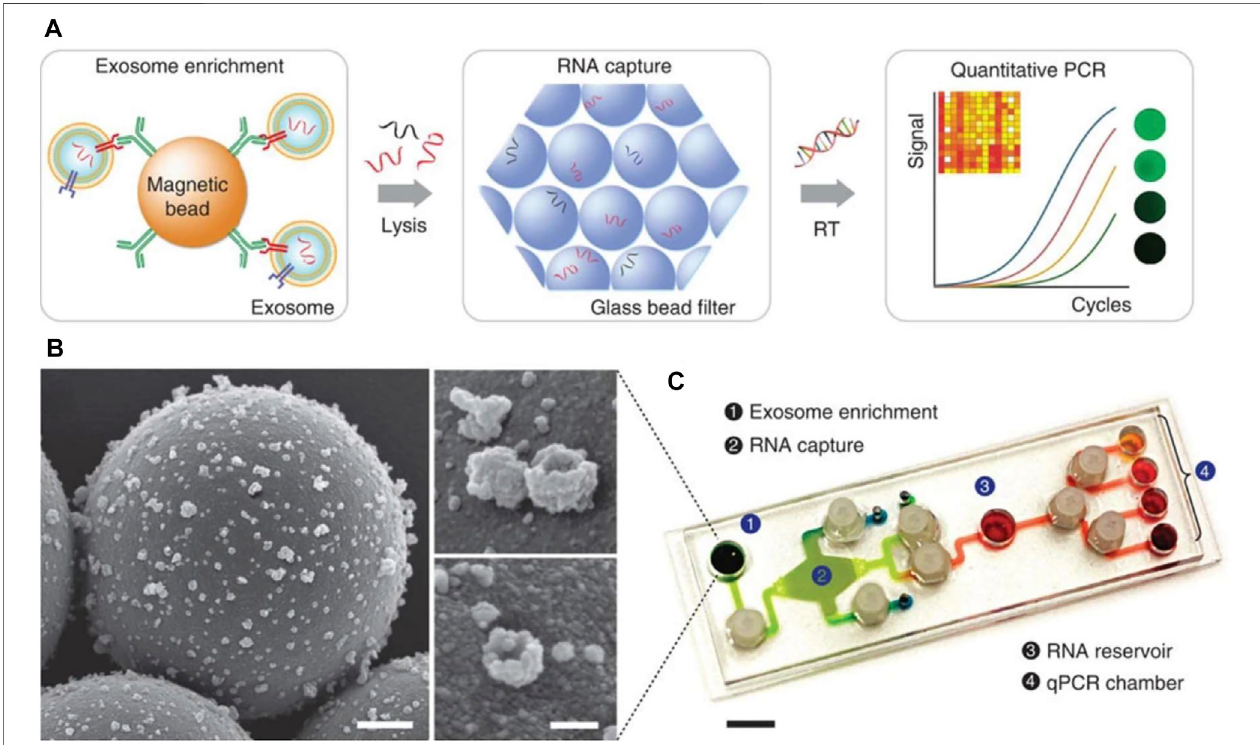
FIGURE6| Diagramofkeysteps/approachesformeasuringexosomeforthepredictionofCVD. (A) Magneticmicrobeadscoatedwithspeci fi cantibodiesenabled exosomeisolationandadditionofguanidine-basedlysisbufferreleasedthecontentsofenrichedexosomes.Torque-actuatedvalvesandpermanentmagnetswereused to control the process. RNA is adsorbed on a glass-bead fi lter via electrostatic interactions and reagents are loaded to prepare for qPCR. (B) Images from scanning electron microscope of exosomes captured on antibody-coated magnetic microbeads. Scale bars 500 and 100 nm (inset) (C) Photograph of PDMS iMER cartridge. RT — Reverse transcription (Shao et al., 2015). Source: Reprinted in its original form under CC BY license. License access: https://creativecommons.org/ licenses/by/4.0/legalcode.